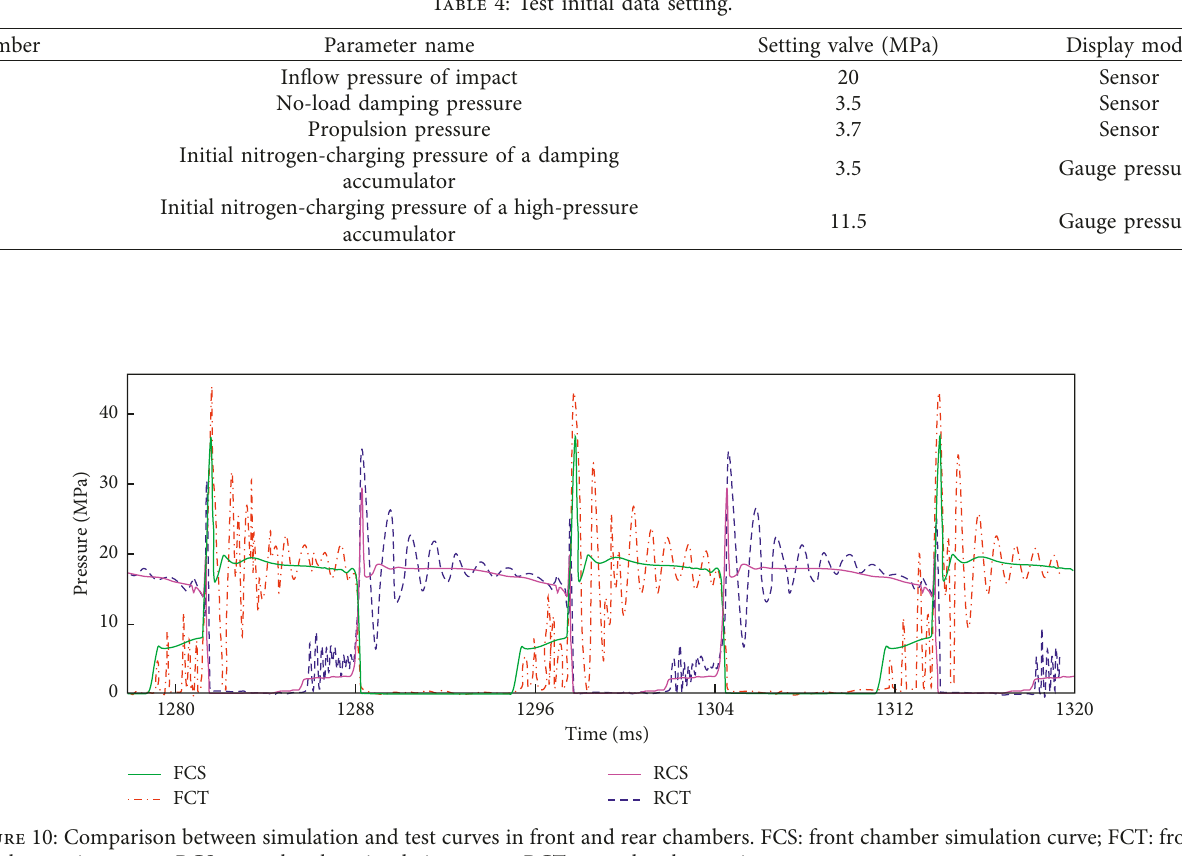
Figure 10: Comparison between simulation and test curves in front and rear chambers. FCS: front chamber simulation curve; FCT: front chamber testing curve; RCS: rear chamber simulation curve; RCT: rear chamber testing curve.